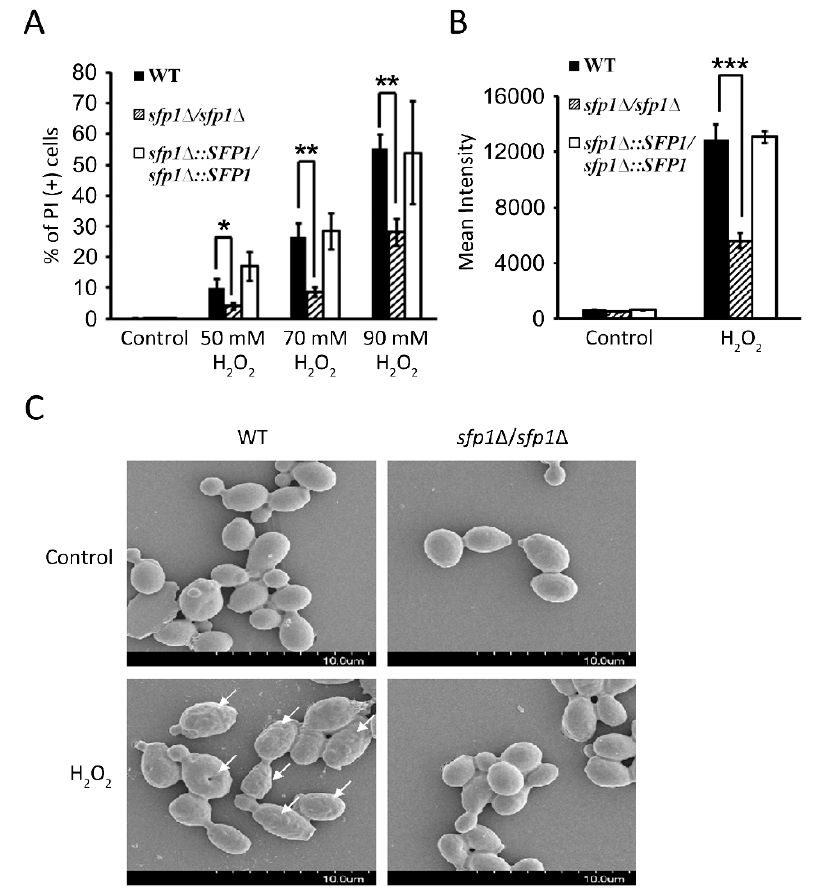
Figure 4. Susceptibility of C. albicans to H 2 O 2 and H 2 O 2 -induced intracellular ROS generation. ( A ) Cells were treated with various concentrations of H 2 O 2 as indicated for 2 h and stained with 4 μ g/mL PI. Cell viability was then quantified by flow cytometry. The dead cells are represented as PI-positive cells. ( B ) Cells were treated with 30 mM H 2 O 2 for 2 h and stained with 20 μ g/mL H 2 DCFDA. Intracellular ROS were quantified by flow cytometry. The results are presented as the mean ± standard deviation (SD) of three independent experiments. *** P < 0.001. ** P < 0.01. * P < 0.05. ( C ) Cells were treated with 30 mM H 2 O 2 for 2 h. Cell surface structure was examined using SEM at 5,500× magnification. Arrows point to the rough appearance of protrusions and disc-like depressions.